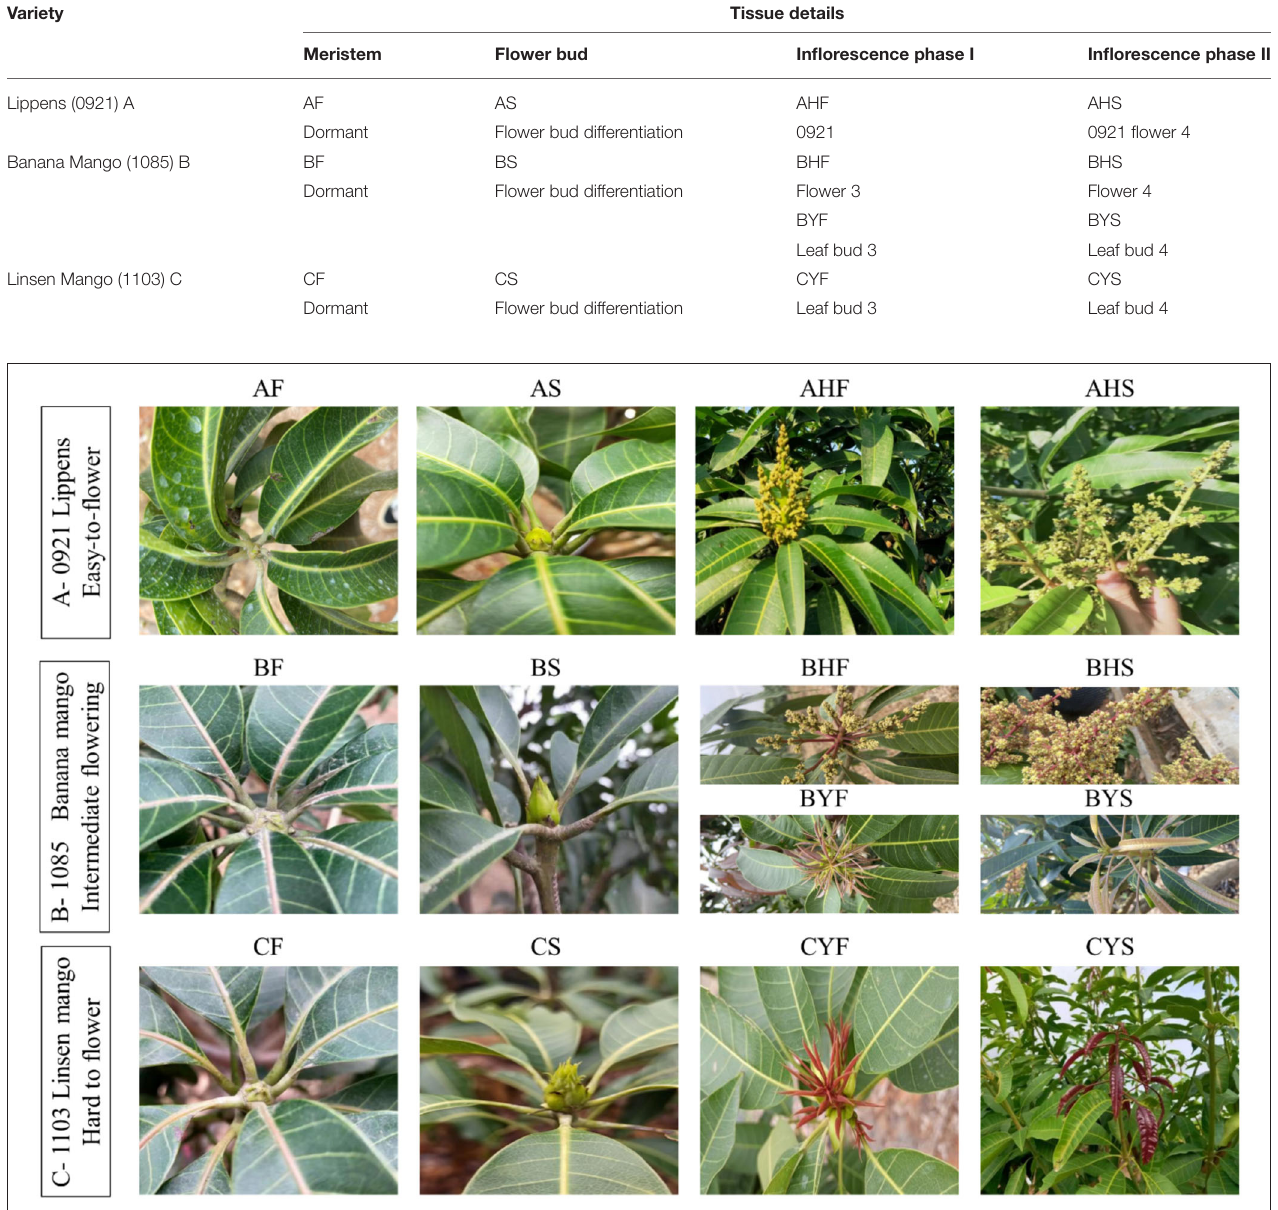
FIGURE 1 | A representation of stages of flowering in mango. The samples were collected from distinct stages for the analysis of transcriptome and metabolome.